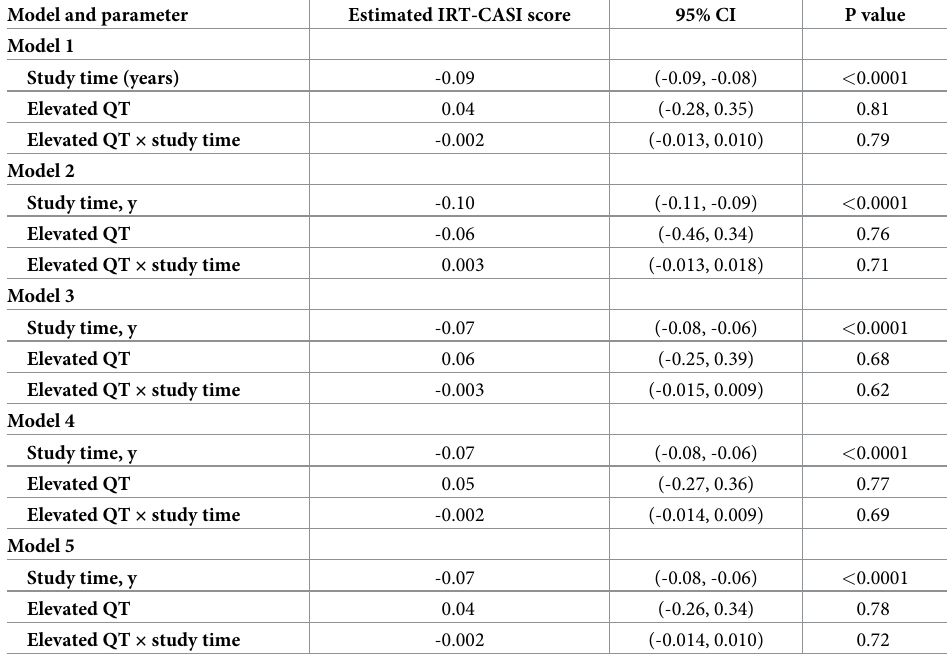
Table 2. Association of elevated QT interval in midlife with item response theory-adjusted Cognitive Abilities Screening Instrument (IRT-CASI) score later in